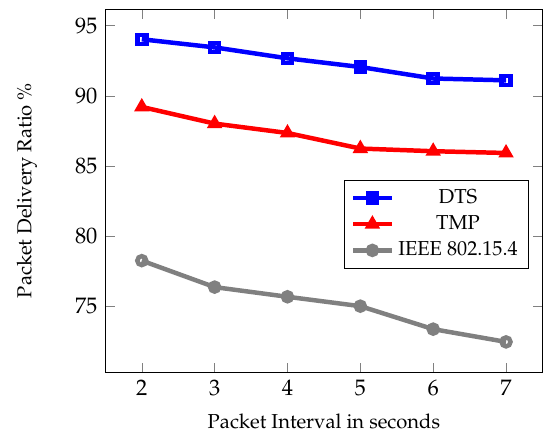
Figure 10. Packet delivery ratio under different packet intervals.